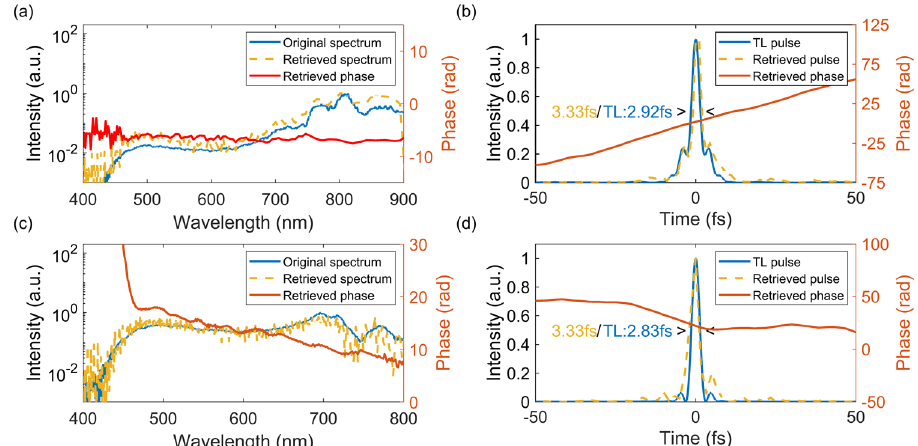
Figure 2. PG-XFROG measurement result of probe and pump pulse at the sample position. with ( a ) probe and ( c ) pump spectra directly recorded from the spectrometer (blue) and spectrum reconstructed from PG-XFROG trace (dashed orange) with phase (red). ( b ) and ( d ) are the reconstructed temporal intensity (dashed orange) and phase (red) of probe and pump pulse, respectively. The transform limit (blue) is obtained by directly using the Fourier transformation on the spectrometer